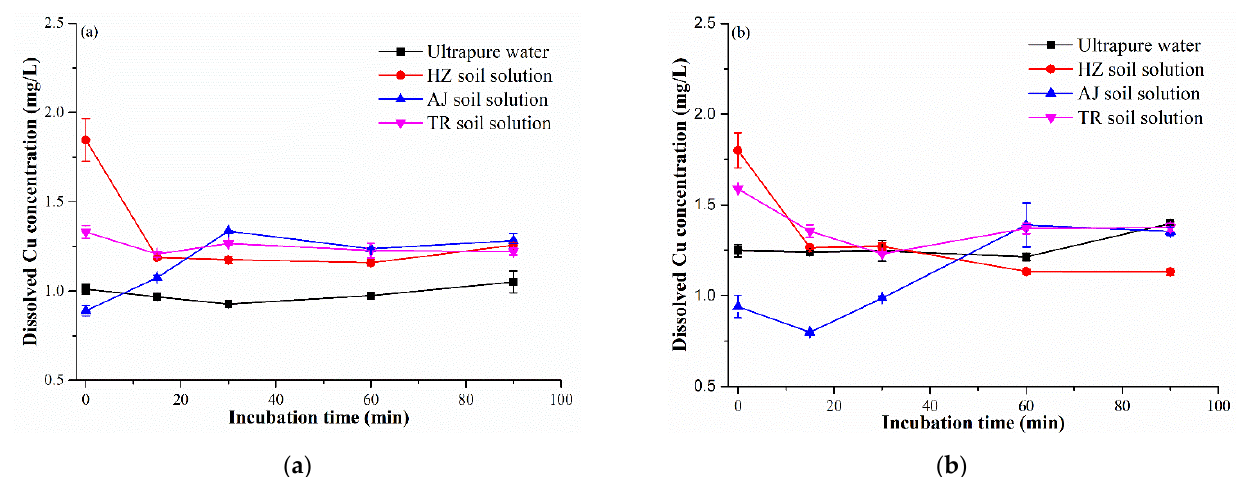
Figure 3. Dissolved Cu concentration as a function of incubation time: ( a ) NPF; ( b ) AI.